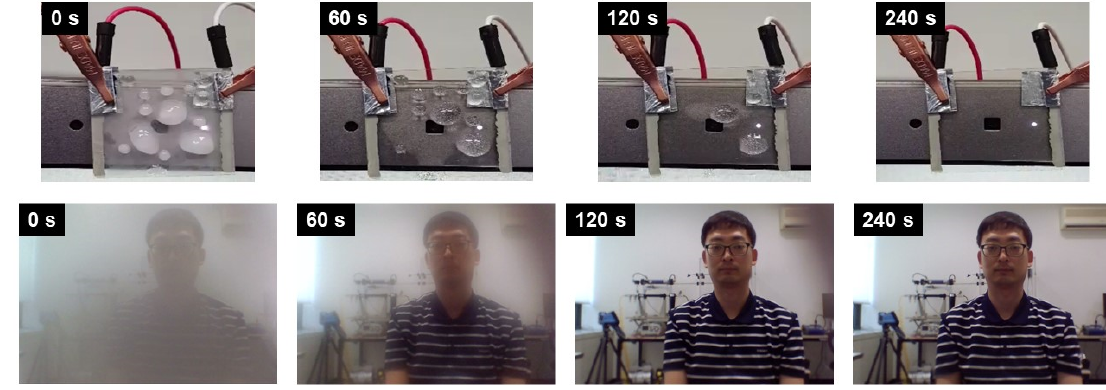
Figure 3. Photograph and infrared (IR) images of the ITO/Ag/ITO multilayer transparent heater attached to the built-in webcam of a laptop.